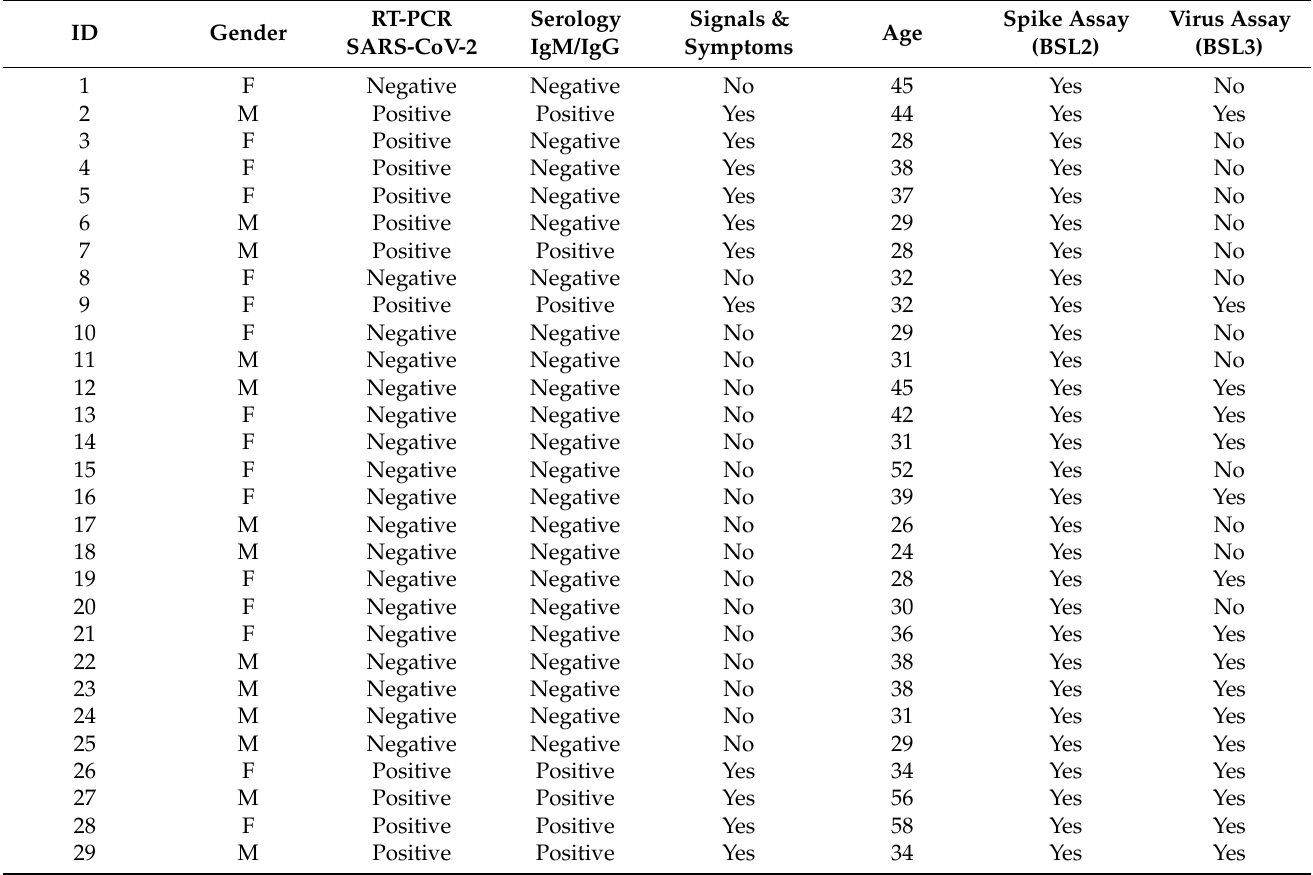
Table 1. Clinical characteristics of the study population.